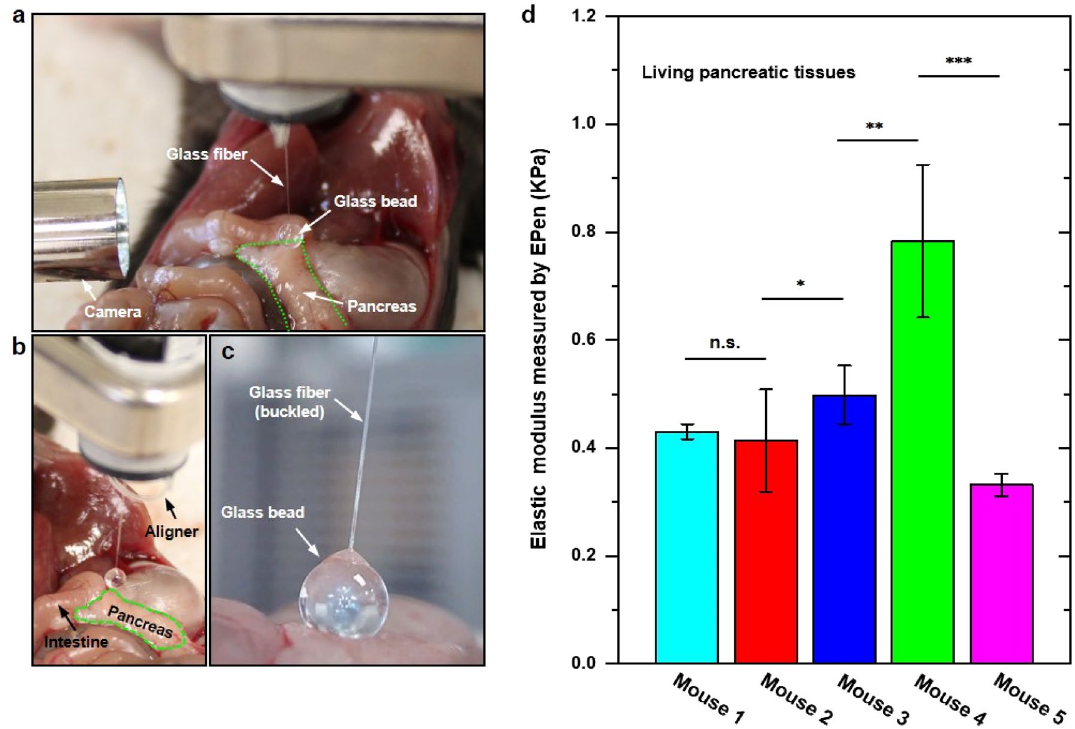
Figure 5. Application: measuring mouse pancreas stiffness. ( a – c ) Optical images of the EPen used for stiffness measurements of the soft pancreas tissue in vivo. ( d ) Measured elastic modulus of healthy and cancerous mouse pancreas by EPen. Data represent mean ± standard deviation. n = 3 EPen measurements for mouse 1 and 5, n = 11 EPen measurements for mouse 2, n = 9 EPen measurements for mouse 3, and n = 7 EPen measurements for mouse 4. Statistical significance is assessed using a two-tailed unpaired t-test (*p < 0.05, **p < 0.005, ***p <